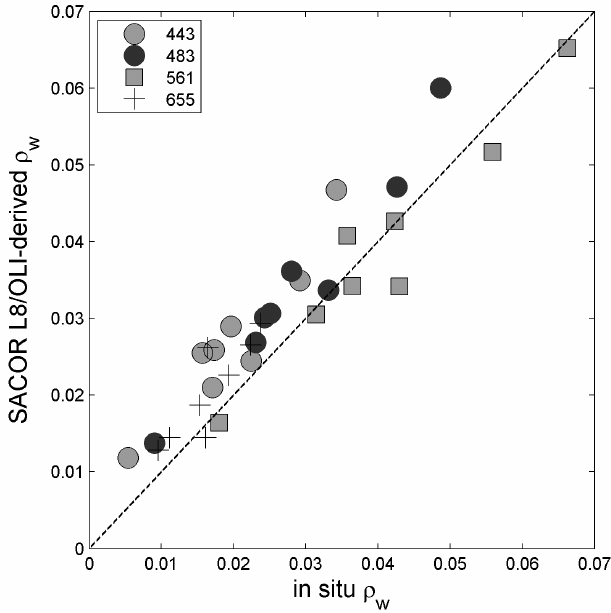
Figure 9. Comparison between the SACOR satellite-derived and relative spectral response (RSR)-adjusted in-situ ρ w for the match-up sets (N = 8). Symbols indicate the values of ρ w at the four Operational Land Imager (OLI) spectral bands located in the visible wavelengths. The dashed line represents the 1:1 line.